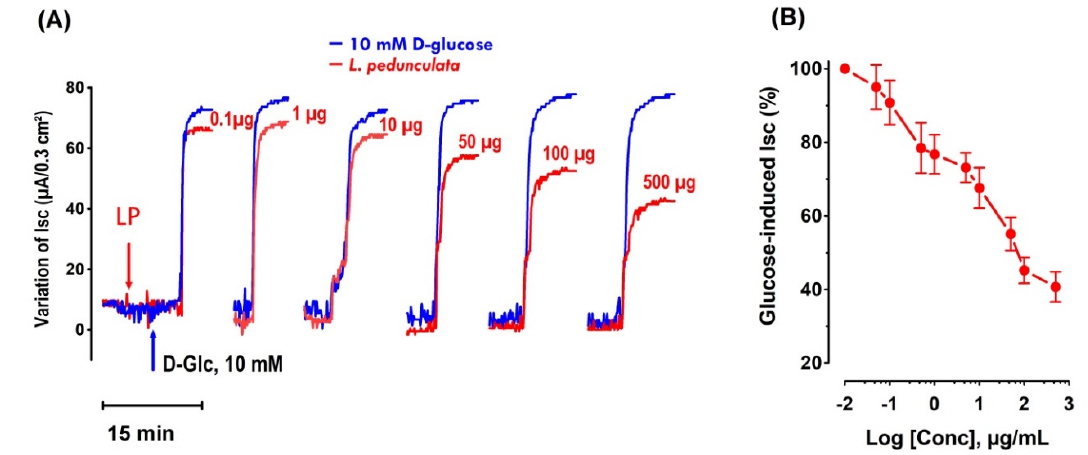
Figure 6. Effect of LP aqueous extract on the glucose-induced I sc . ( A ) Typical recording of the I sc (µA/0.3 cm 2 ) inhibition across mouse jejunum fragment in Ussing chambers by the addition of LP on the mucosal side 5 min before adding the D-glucose (10 mM) into the same side. This figure showed that LP induced a concentration-response inhibition of I sc . Increase in I sc reflects a sodium-dependent glucose absorption through the sodium-glucose cotransporter-1 (SGLT1). The plateau represents the maximum increase in I sc . ( B ) Represents the concentration–response curve related to the use of LP extract. n = 6–7 tissues studied.